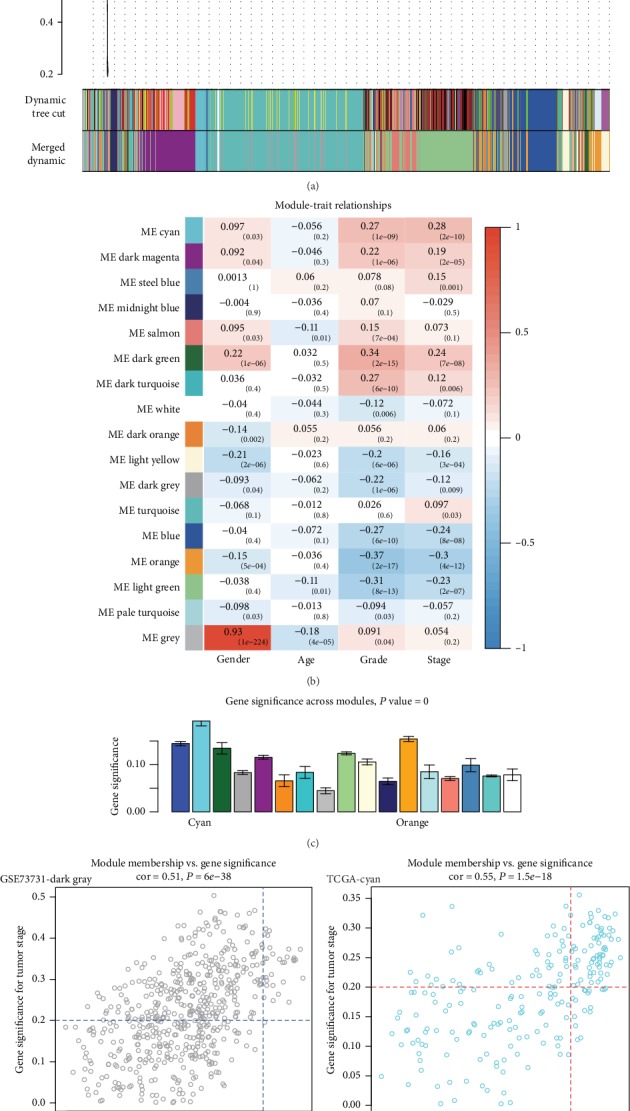
Weighted gene coexpression analysis for TCGA and screening for intramodular hub genes of key modules. (a) The clustering dendrogram based on the dissimilarity (1-TOM) using the dynamic tree cut method. (b) Module-trait relationship heat map based on the Pearson correlation coefficient between module eigengenes and clinical parameters (gender, age, grade, and stage). (c) Barplot for average gene significance across modules associated with the pathological stage for ccRCC. (d) Scatter plot of module eigengenes in the dark-gray module from GSE73731. (e) Scatter plot of module eigengenes in the cyan module from TCGA. Dots in the upper-right corner in both plots represent hub genes in the module.